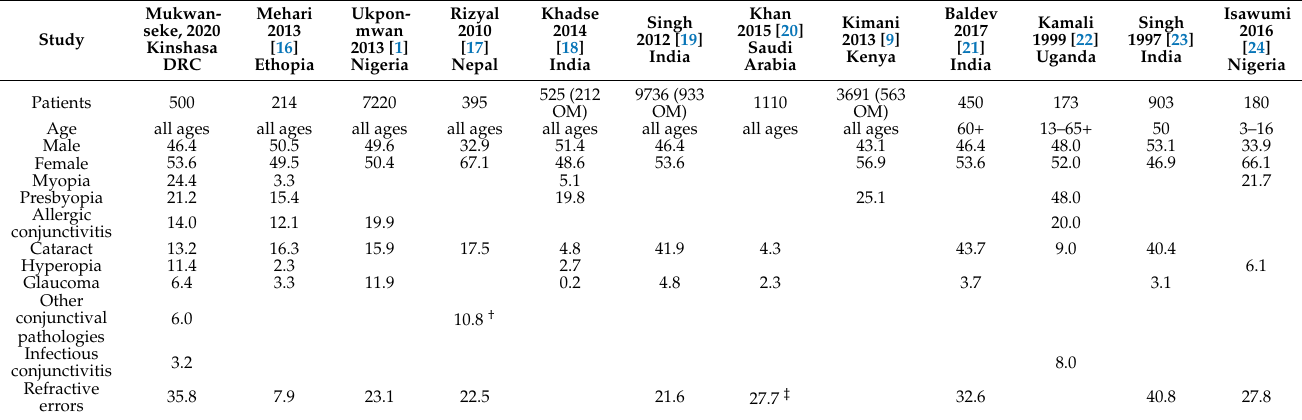
Table 5. Comparison of various studies on ocular morbidity including different regions and ages of patients. Numbers are given in percentage. † Conjunctival degeneration (pterygium, pinguecula), ‡ inclusive presbyopia, OM: ocular morbidity.